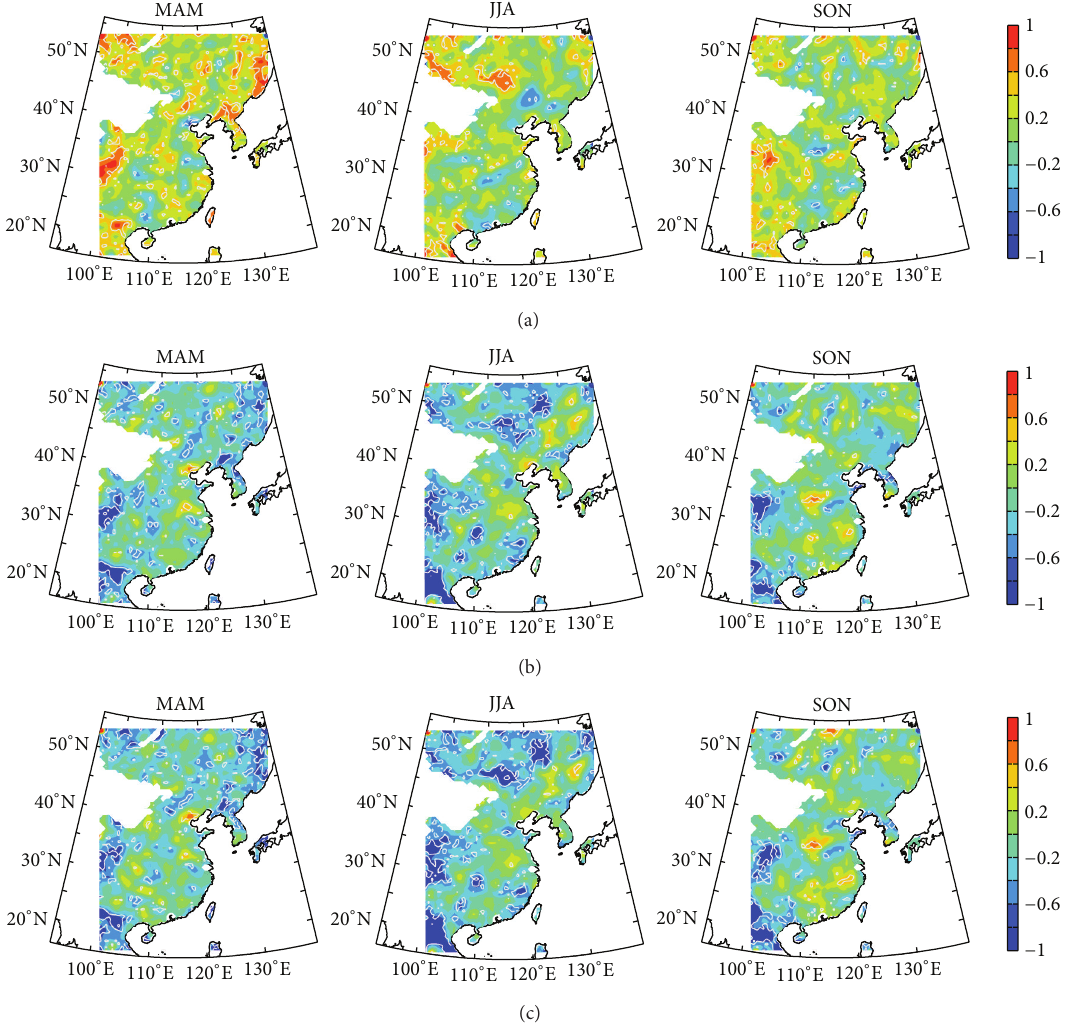
Figure 8: Correlations between LAI anomaly and differences in the simulated latent heat flux (a), sensible heat flux (b), and surface Bowen ratio (c) from DYC simulation and FIX simulation (DYC minus FIX) for spring (March to May; MAM), summer (June to August; JJA), and autumn (September to November; SON) (white lines denote a confidence level higher than